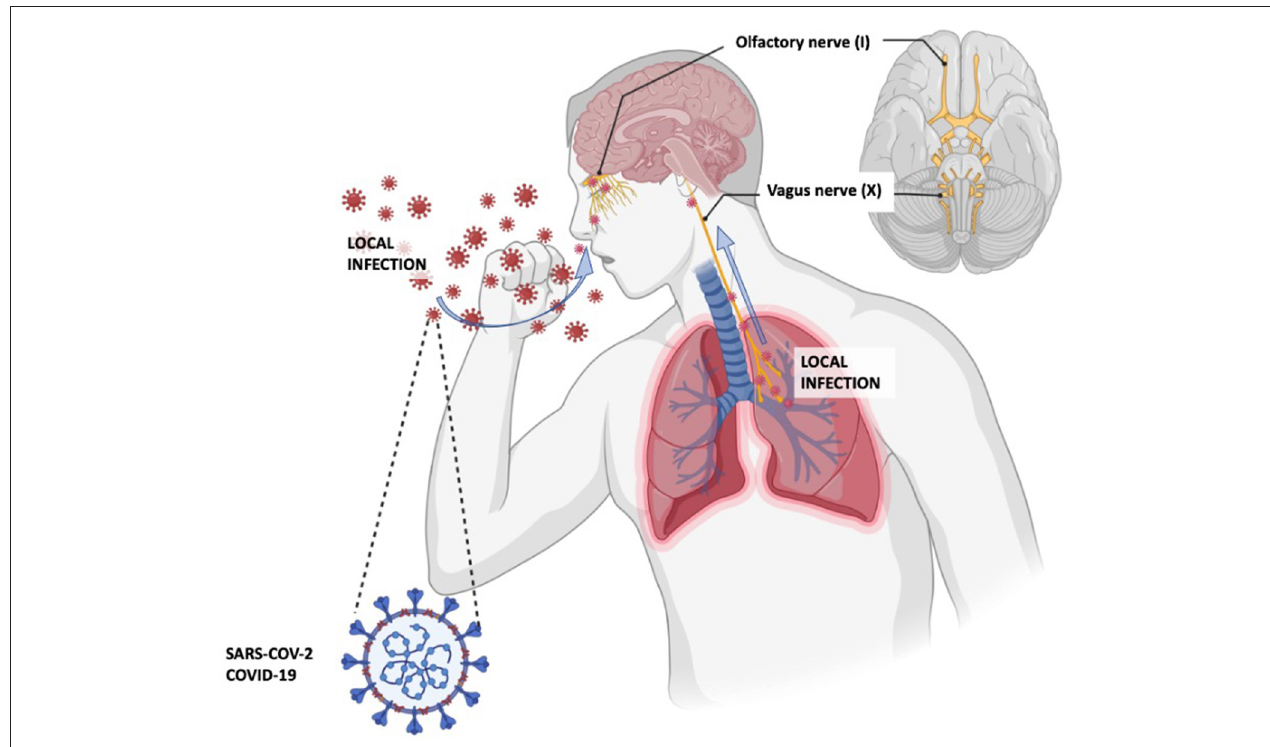
FIGURE 2 | Proposed COVID-19 pathways to the central nervous system. Adapted from the article by Yachou Y et al.